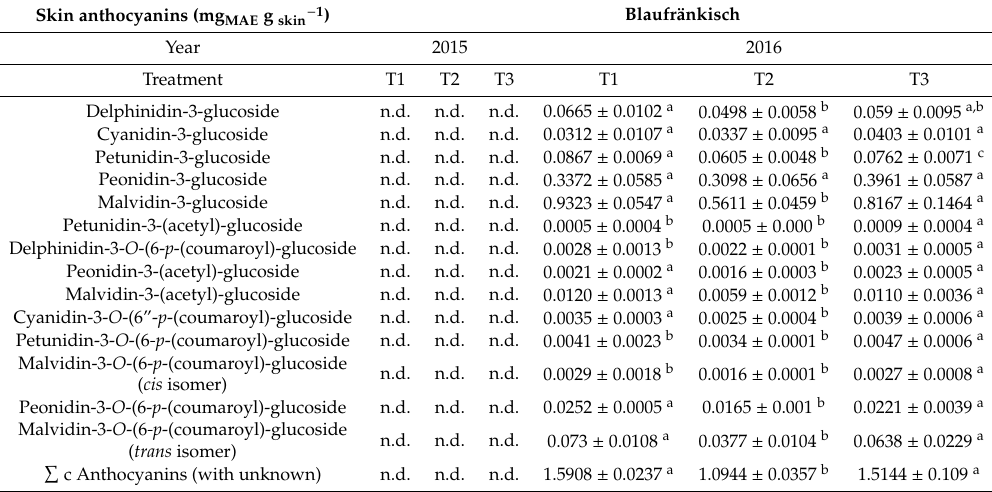
Di ff erent superscript lower case letters in each row indicate statistically significant di ff erences ( p < 0.001) between treatments. Table 3. Individual anthocyanins concentration in grape skin extracts expressed as mg of MAE per g of grape skin for Merlot variety.